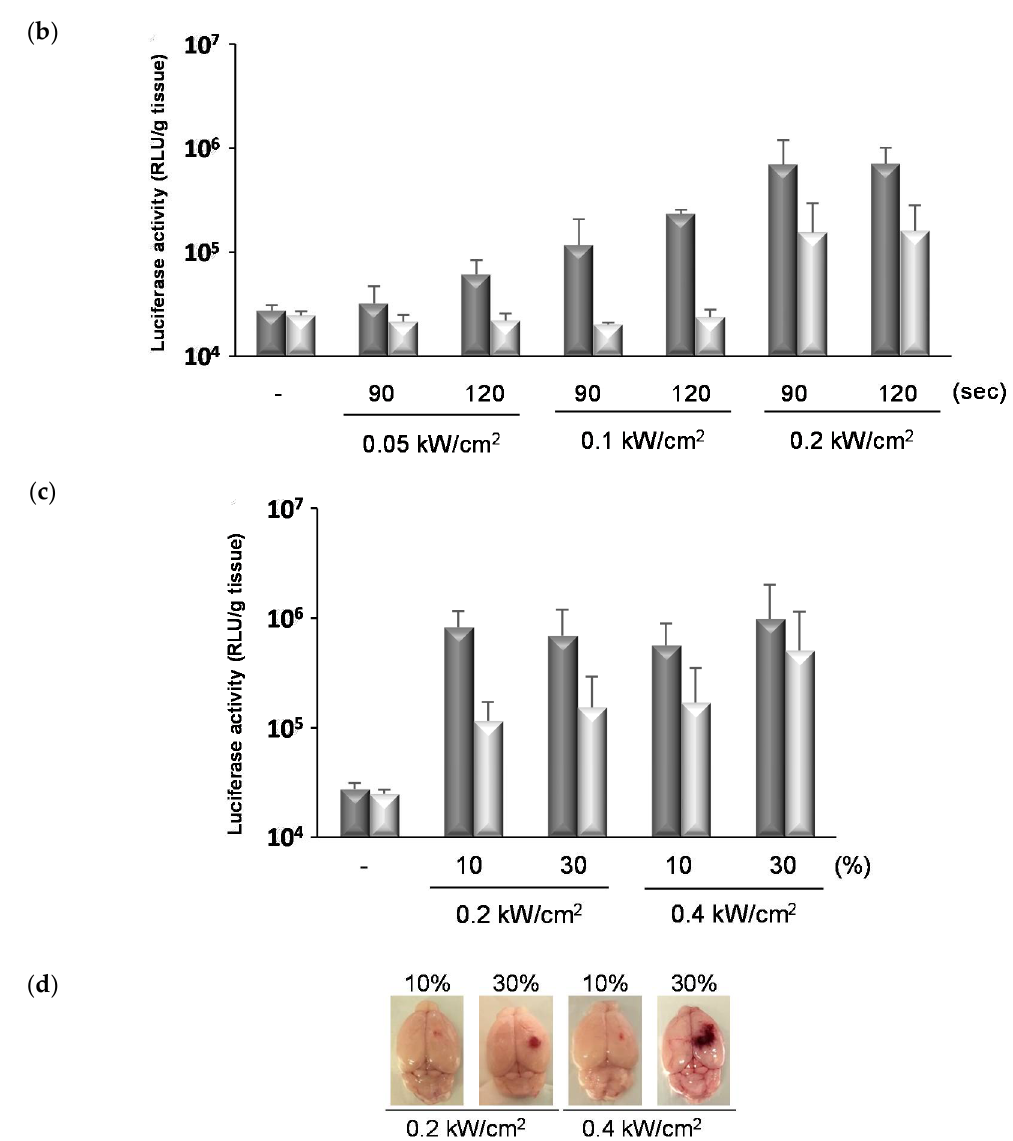
Figure 5. The effects of FUS conditions on the gene transfection effects into the brain tissue. The ternary complexes (pDNA 48 μg/mouse, N/P 10, PEG-PEI:RVG-R9 = 8:2) and NBs (100 μg/mouse) were injected into the tail vein of mice and the right hemisphere was concurrently exposed to FUS. The FUS conditions for each study are as follows: ( a ) intensity: 0.05–0.4 kW/cm 2 , duty: 30% (sec), time: 90 s, ( b ) intensity: 0.05–0.2 kW/cm 2 , duty: 30% (sec), time: 90 or 120 s, ( c , d ) intensity: 0.2 or 0.4 kW/cm 2 , duty: 10 or 30% (sec), time: 90 s. One day after the transfection, the brain tissues were collected and the luciferase activity was analyzed. The bars show the mean and S.D. ( n = 3–6). Dark gray column: the right hemisphere exposed to FUS. Light gray column: the left hemisphere unexposed to FUS. ( d ) The tissue damages by NBs and FUS 1 day after the transfection.